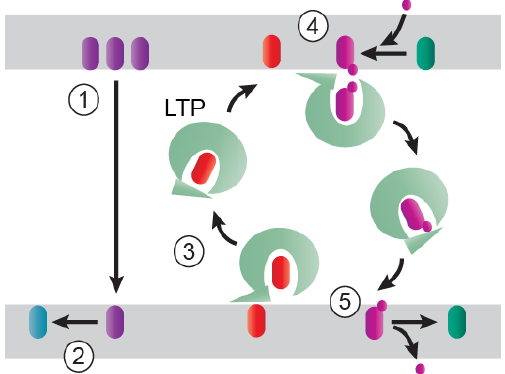
Figure 1. Potential mechanisms involved in non-vesicular lipid transport at membrane contact sites (MCSs). Spontaneous lipid transfer (1; purple lipid) could be aided by a sink capable of driving transport down a chemical concentration gradient by lowering the concentration of the transferred lipid in the acceptor membrane (2; blue lipid). Lipid transport could also be mediated by lipid transfer proteins (LTPs) that extract one lipid from a donor membrane (3; orange lipid) and deliver it in a sealed hydrophobic pocket to an acceptor membrane, where it is exchanged for a second lipid generated in the acceptor compartment (4; magenta lipid). In this model, LTP-dependent lipid transport is driven by a concentration gradient that is maintained by the continuous hydrolysis of the transported lipid in the donor compartment (5; green lipid).